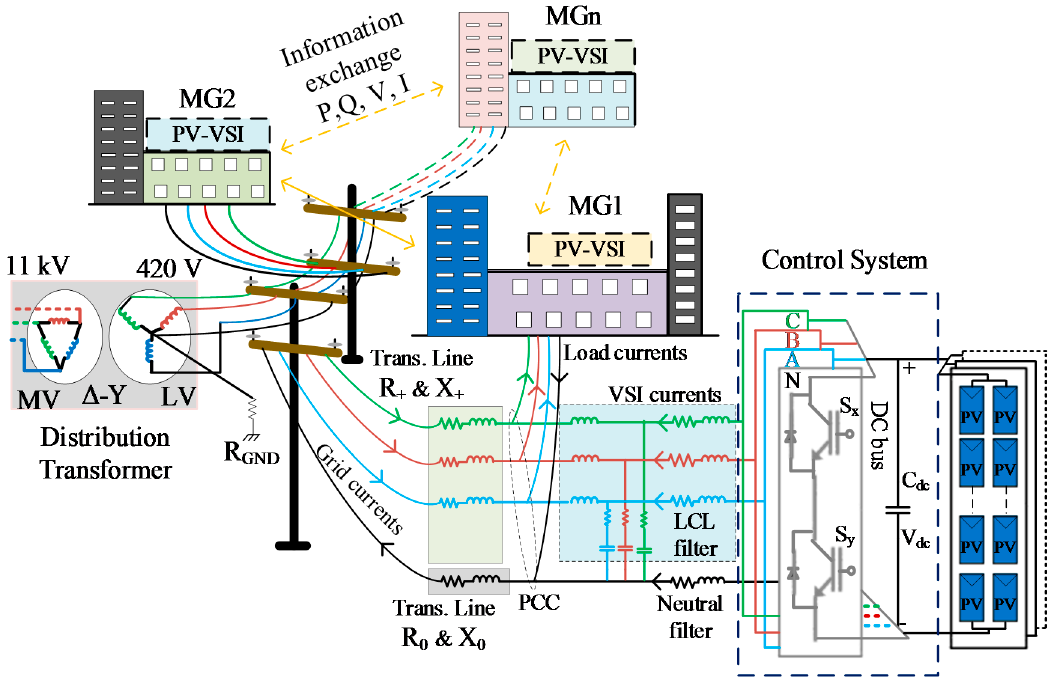
Figure 1. Multi-Microgrid (MMG) system architecture.